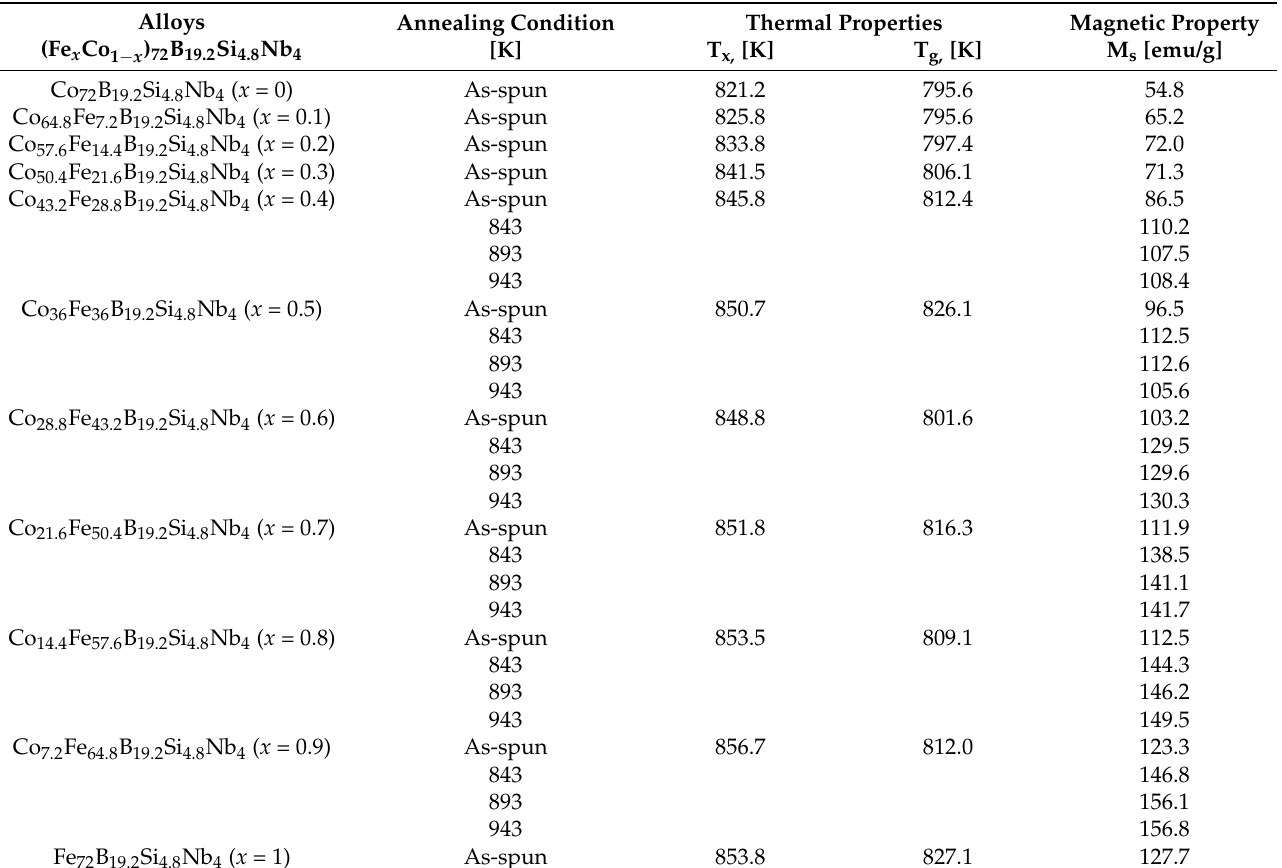
Table 1. Thermal and magnetic properties of the (Fe x Co 1 − x ) 72 B 19.2 Si 4.8 Nb 4 (0 ≤ x ≤ 1, at 0.1 intervals) as-spun and annealed